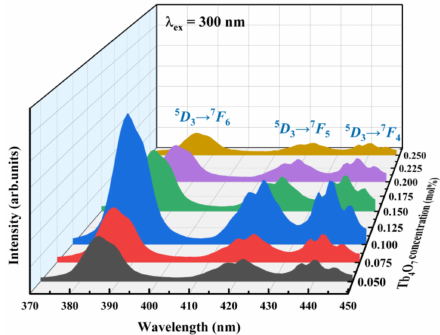
Figure 12. Expansion of the emission spectra in the range 370–450 nm of (ZrO 2 ) 92 (Y 2 O 3 ) 8 − x (Tb 4 O 7 ) x ( x = 0.050–0.250) crystals before